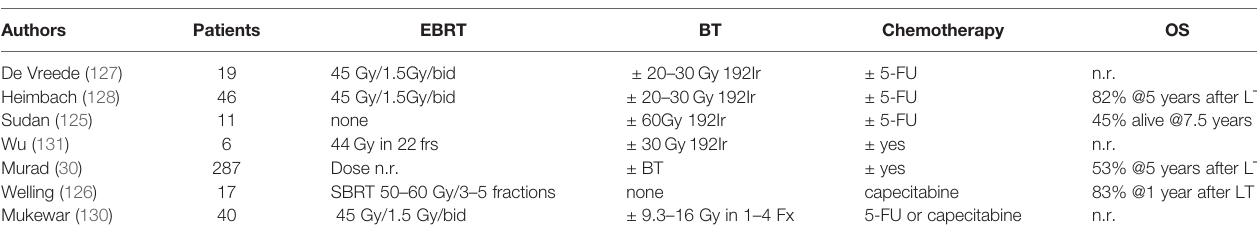
TABLE 4 | Neoadjuvant radiotherapy followed by liver